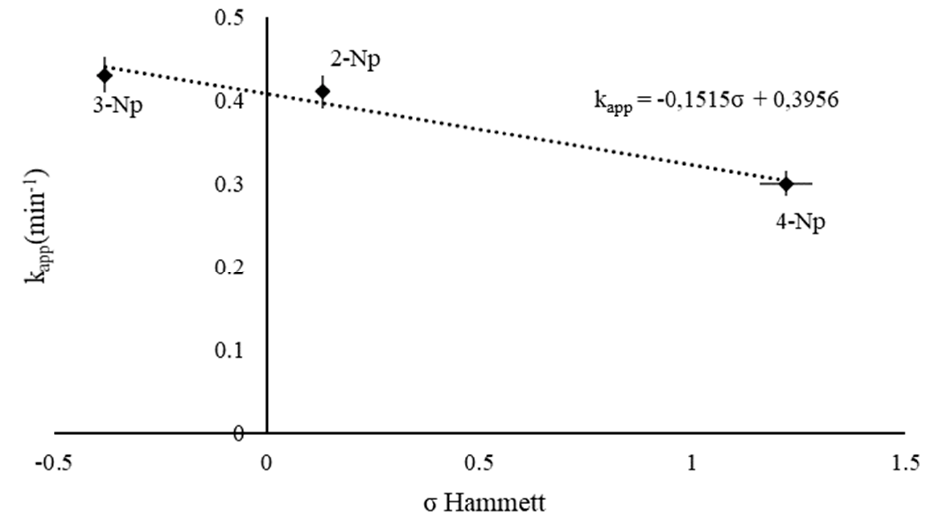
Figure 7. Hammett plot for the effect of the substituent in nitrophenol’s isomer on the catalytic activity, reaction carried out using 25 mL of NP (2 × 10 − 4 M), 25 mL of NaBH 4 (9.0 × 10 − 3 M), Au/PVA weight ratio of 1:0.33, 4 mg of catalyst, at 25 °C .